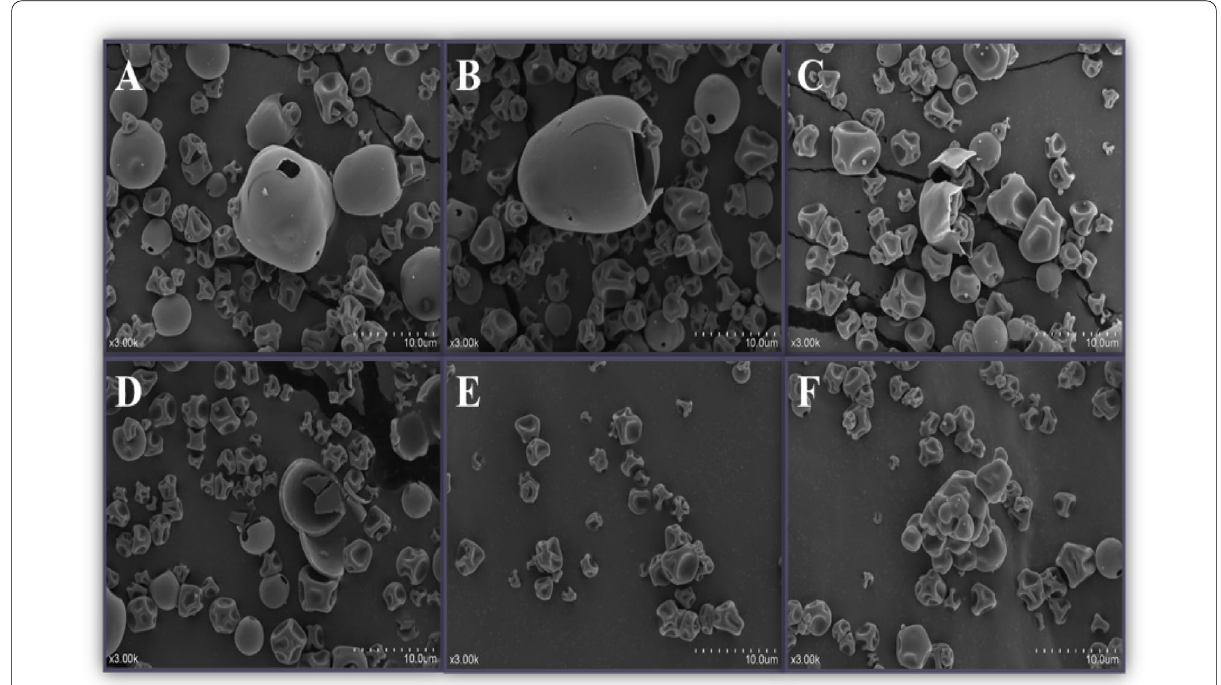
Fig. 5 SEM micrographs of SPH. The letters A – F represent 1–6% DH,